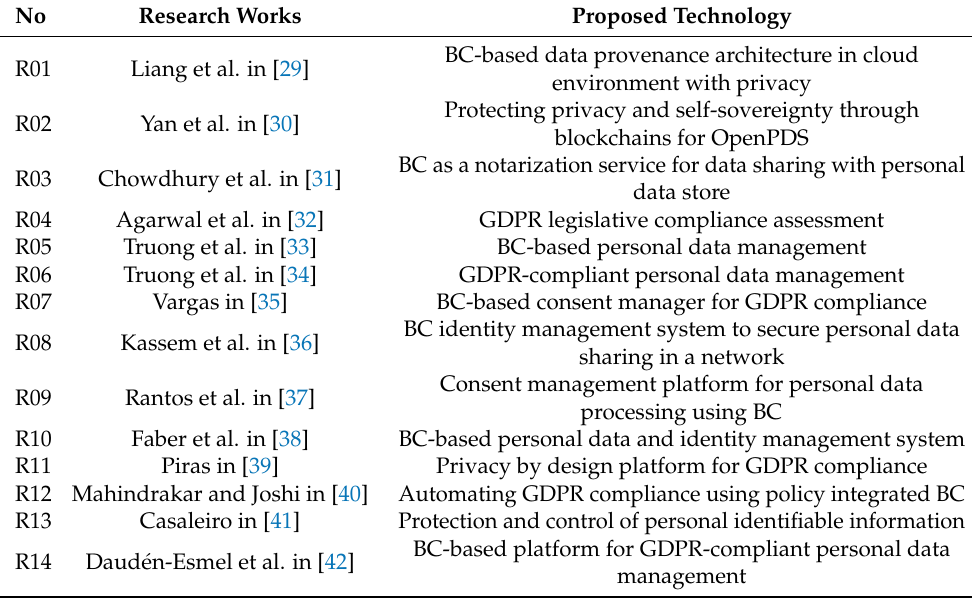
Table 1. Overview of related works based on